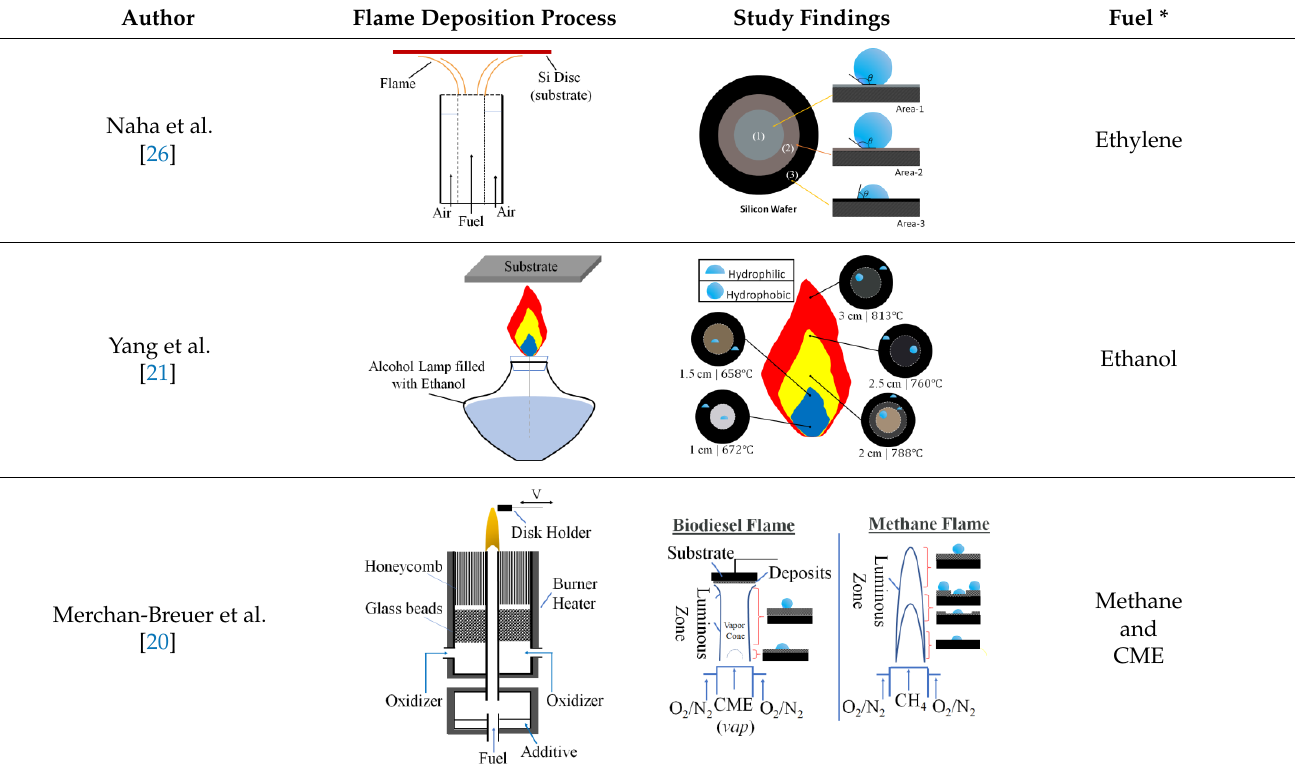
Table 1. Schematic of various flame techniques used to create hydrophobic carbon layers.